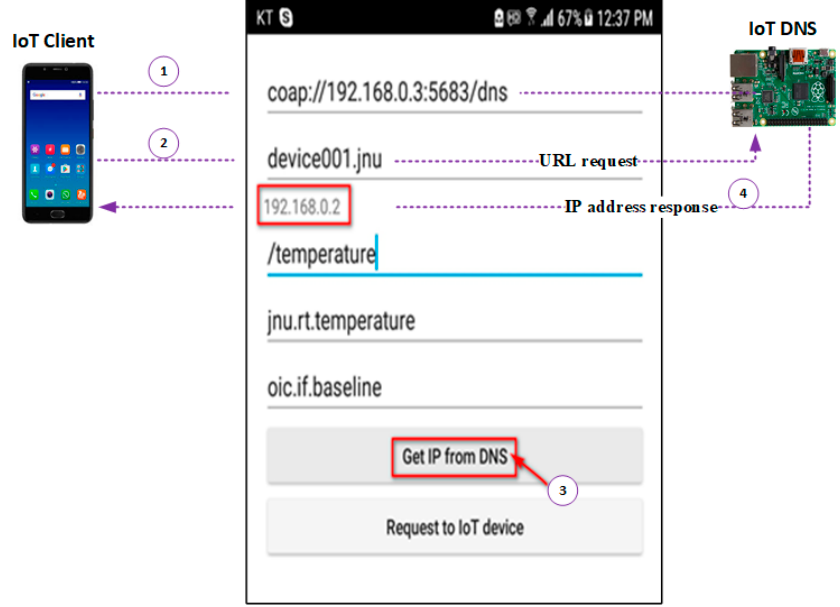
Figure 12. The result of getting an Internet Protocol (IP) address from IoT DNS.